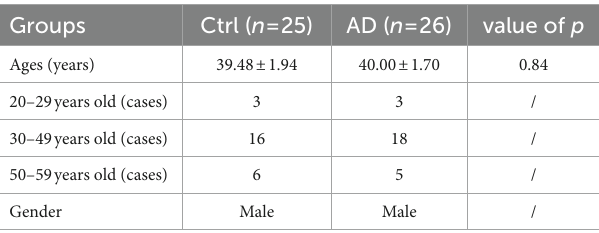
TABLE 1 Clinical data of